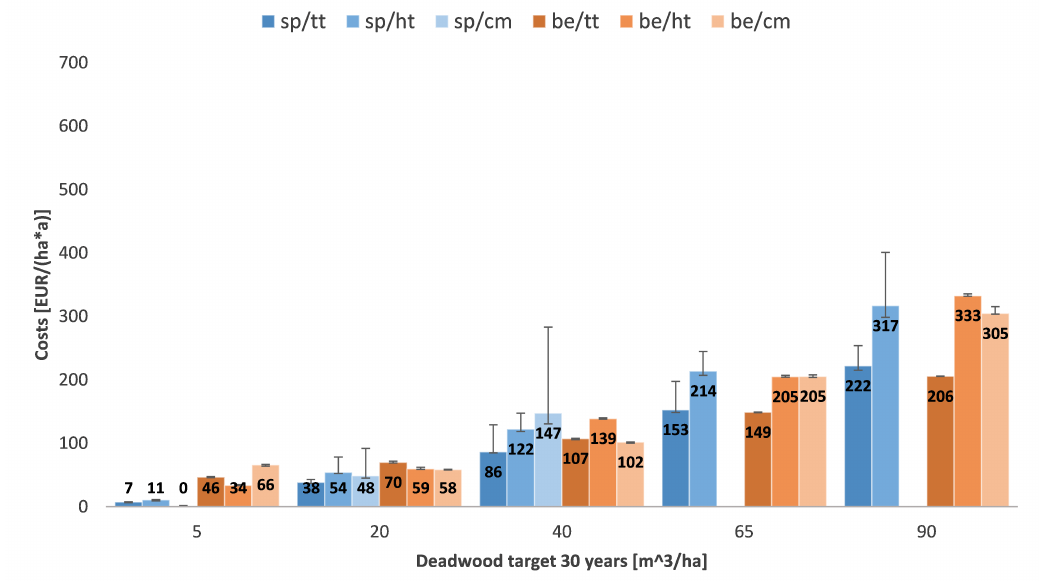
Figure 6. Forest enterprise “Neureichenau”: Costs in [ e ha − 1 a − 1 ] for target deadwood amounts in [m 3 ha − 1 ], to be maintained within 30 years. Blue columns show spruce ( sp ) and orange beech strategies ( be ). tt : Total tree, ht : Heavy timber, cm : Crown